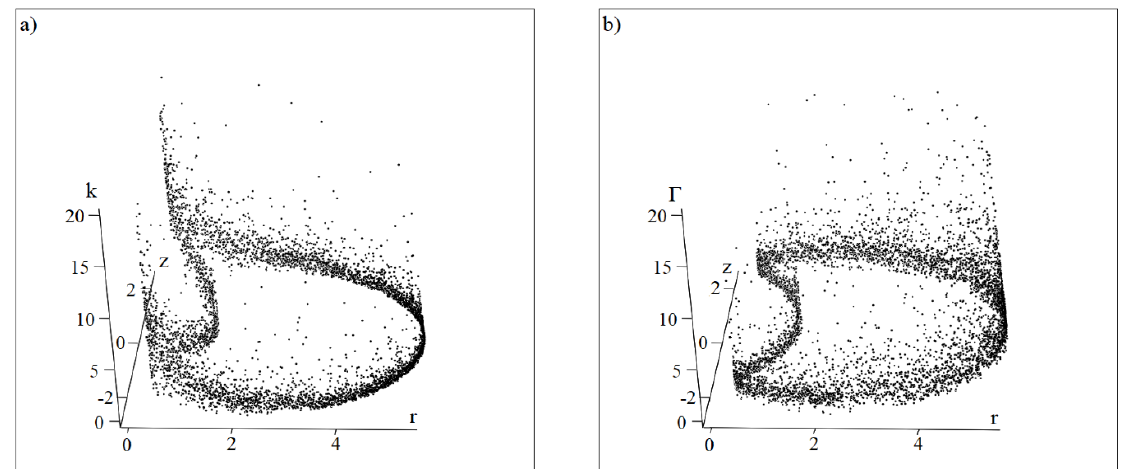
Figure 2. Verification factors at each point of the Ulysses orbit from 1994 to 2009: ( a ) unipolar coefficient k and ( b ) geometric factor Γ . The plane (r, z) corresponds to Figure 1. Distances along r, z are indicated in AU. Daily averaged Ulysses data. The coefficients are dimensionless.